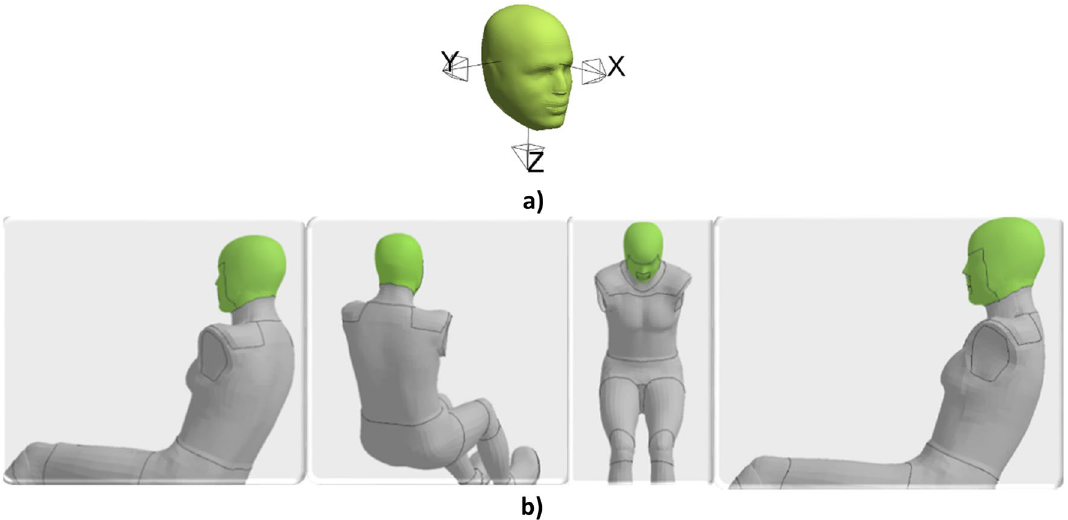
Figure 2. ( a ) Head rotational axes, and ( b ) Views used to generate videos: left isometric, back isometric, front isometric, and